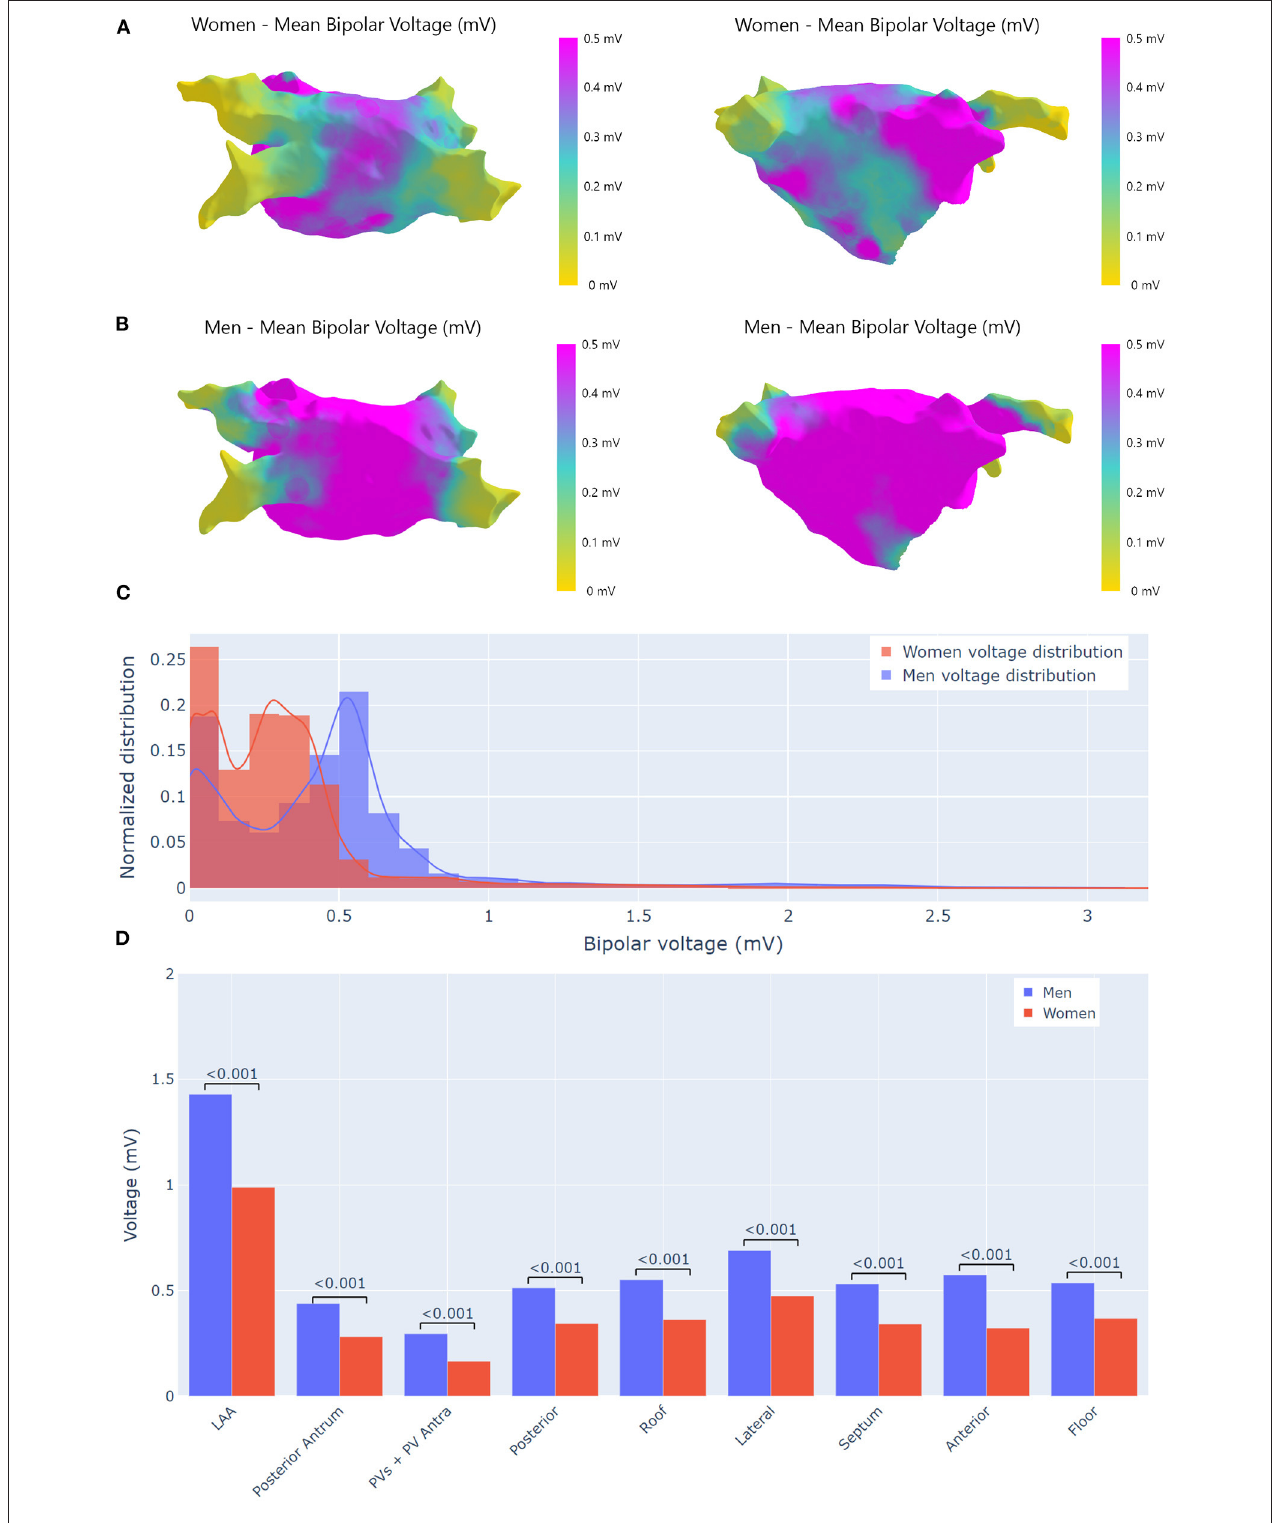
FIGURE 2 | Voltage analysis. (A) Bipolar voltage maps differences by gender. Bipolar voltage maps were obtained averaging all recorded points that were projected onto a reference left atrium (LA) mesh. (A) Averaged bipolar voltage map from 21 women in which the extension of low-voltage areas is appreciated, the LAA seems to avoid the extension of fibrosis. (B) Averaged bipolar voltage map from 64 men where the voltage is preserved in the whole atrium. (C) Bipolar voltage points distributions by gender. (D) Gender bipolar voltage differences by area. Bipolar voltage was significantly higher in men. In women only, the LAA had a voltage higher than 0.5mV. LAA, left atrial appendage; PVs, pulmonary veins.